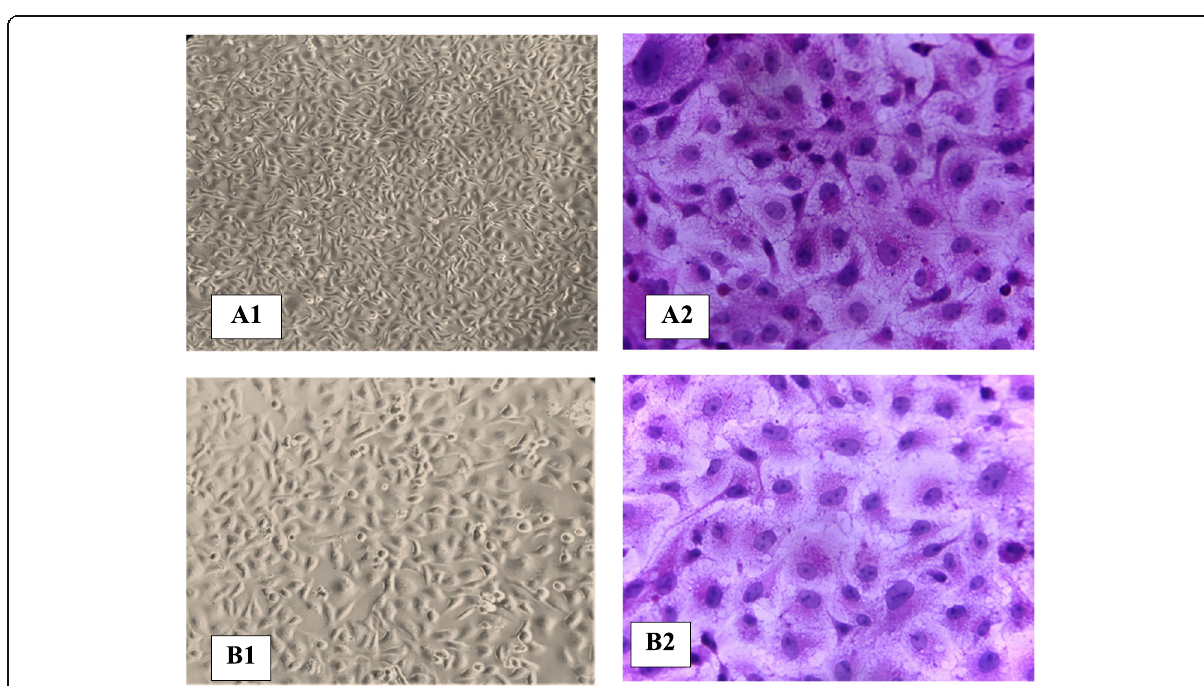
Fig. 2 Effect of nanoparticles on morphology of Vero and MCF-7cells. Hematoxylin and eosin of Vero cell line after 42 h. A1 unstained control confluent monolayer. A2 Stained control confluent monolayer. B1 unstained cells treated with 100 μ g/ml of Ag NPS pure. B2 stained cells treated with 100 mg/ml of Ag NPS